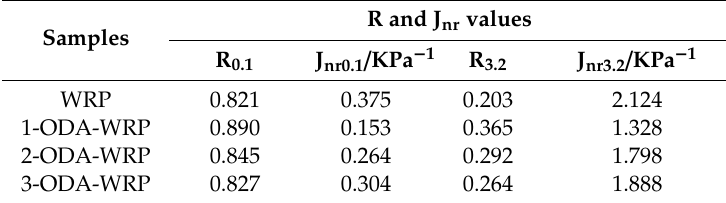
Table 3. R and J nr of various samples at 0.1 KPa and 3.2 KPa (82 ◦